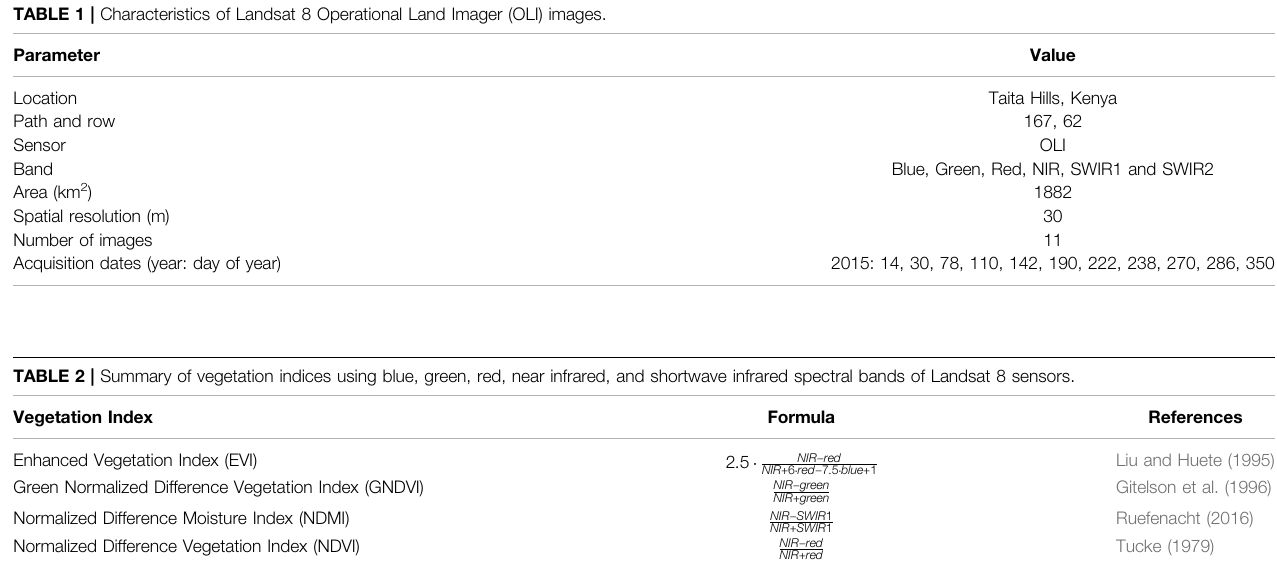
Non-Photosynthetic Vegetation Normalized Difference (NPVND)